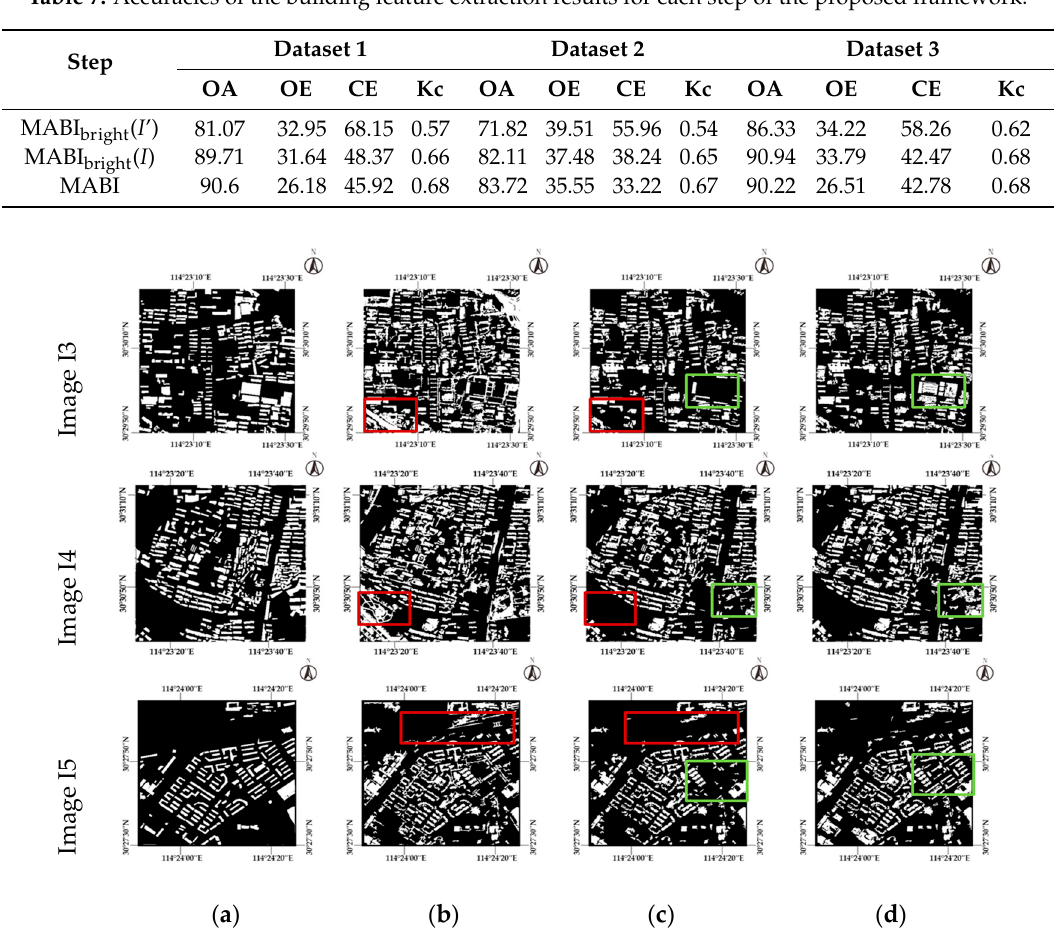
Figure 14. Building feature extraction results of Patches I3, I4, and I5 for step analysis of the proposed method: ( a ) ground truth image; ( b ) result of MABI bright without non-building object detection; ( c ) result of MABI bright ( I ); ( d ) result of the MABI without shadow constraint. The red and green regions emphasize the performance for elongated objects and dark building, respectively. Table 8. Accuracy of the building detection results with different shadow constraints.